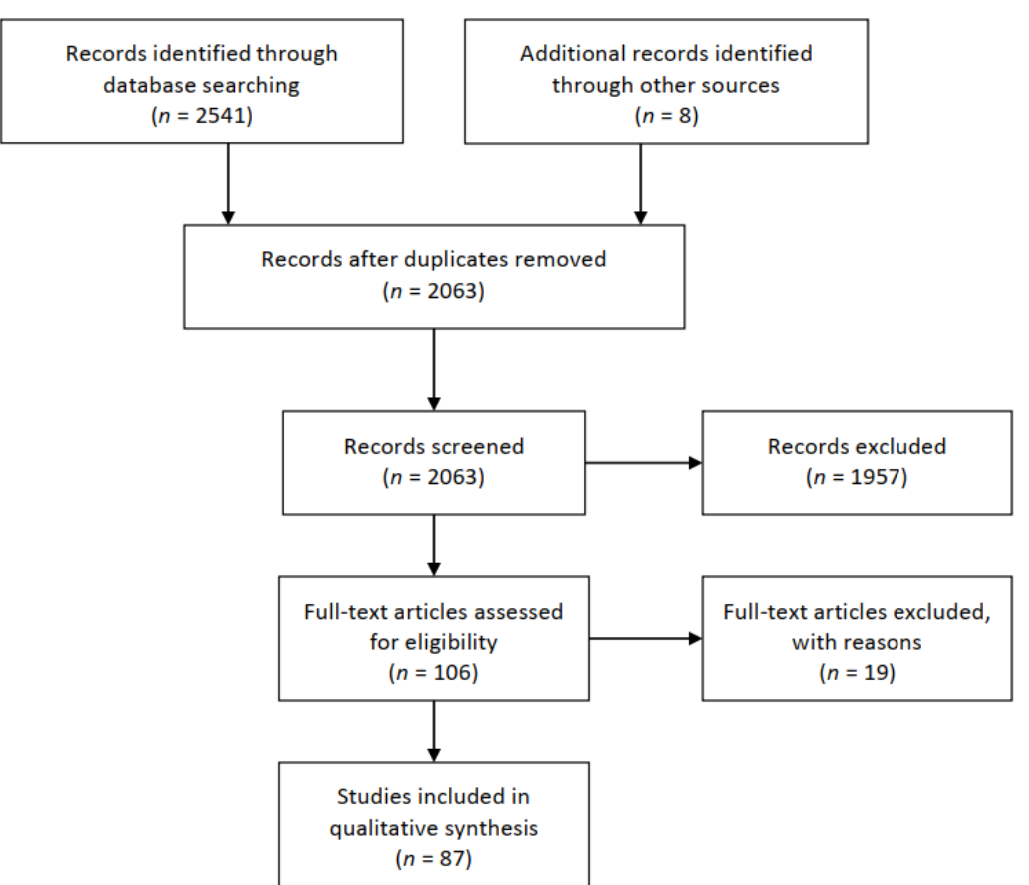
Figure 1. Flow chart of the studies selection.